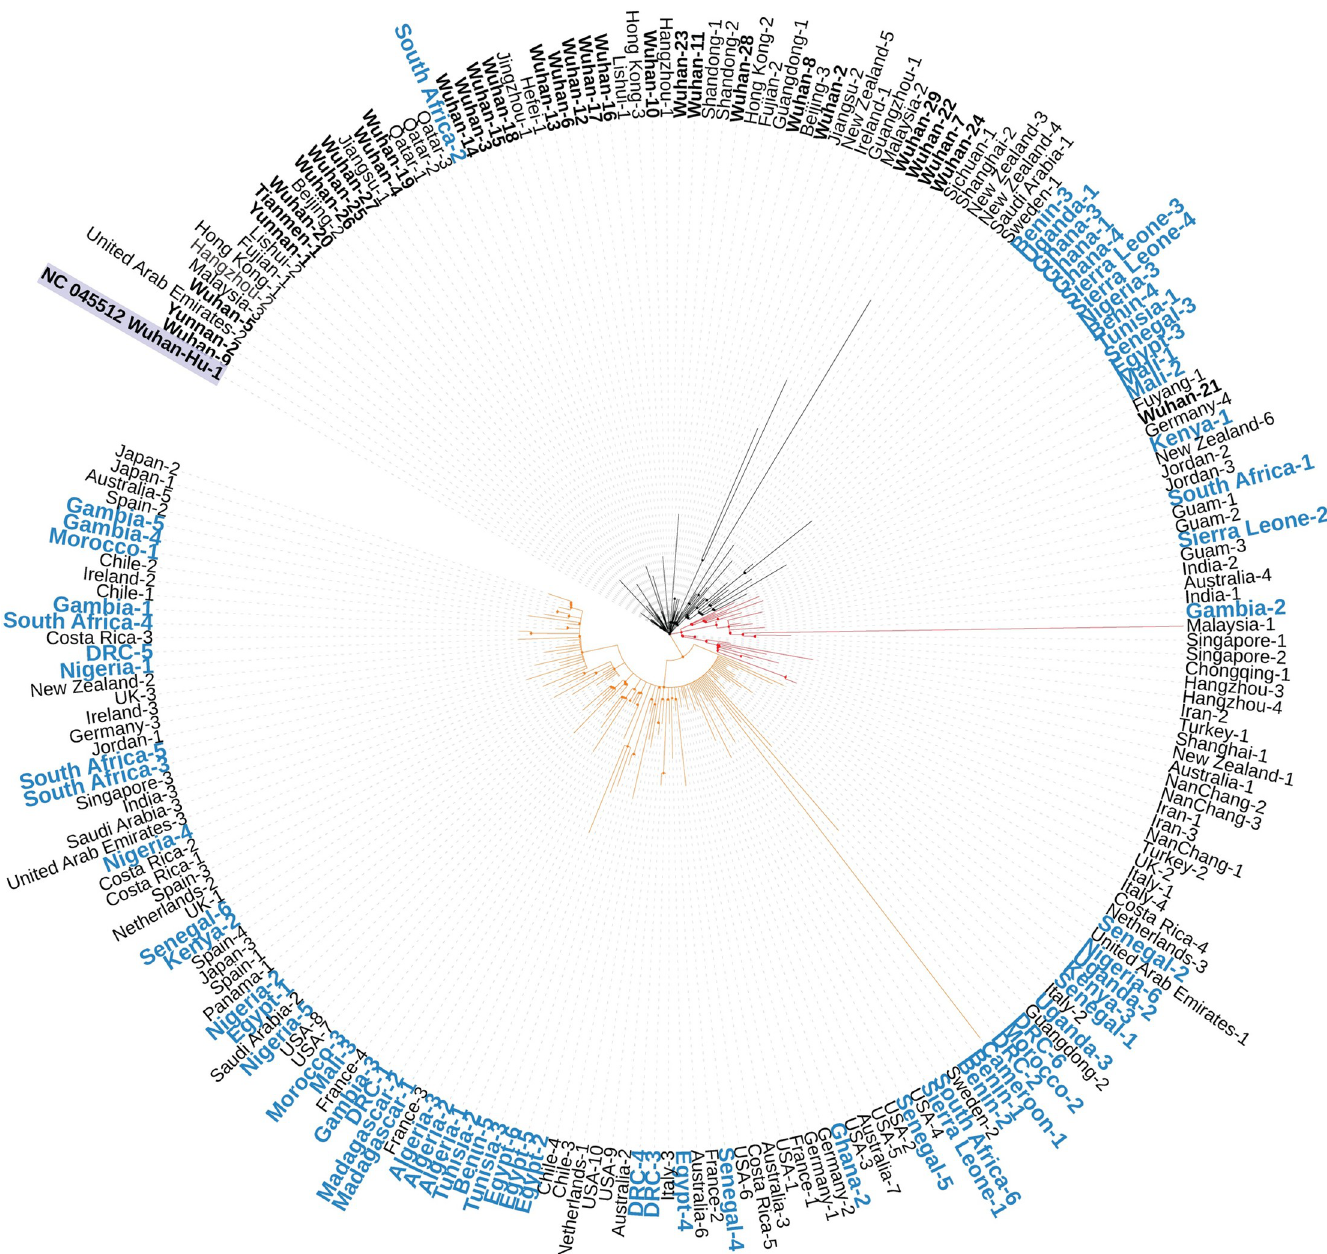
Fig 3. Phylogeny analysis of SARS-CoV-2 in Africa. Phylogeny analysis SARS-CoV-2 using 224 genome sequences form GISAID and NC_045512 reference genome from NCBI. Phylogenetic tree is divided into clades, and all clades are further divided into sub-groups. There were three clades formed: one from the highlighted NC 045512 Wuhan-Hu-1 isolate to Mali-2, another from Fuyang-1 (an isolate from China) to Iran-3, and the last from Nanchang -1 (from China) to Japan-2. Labels in blue represent African countries.